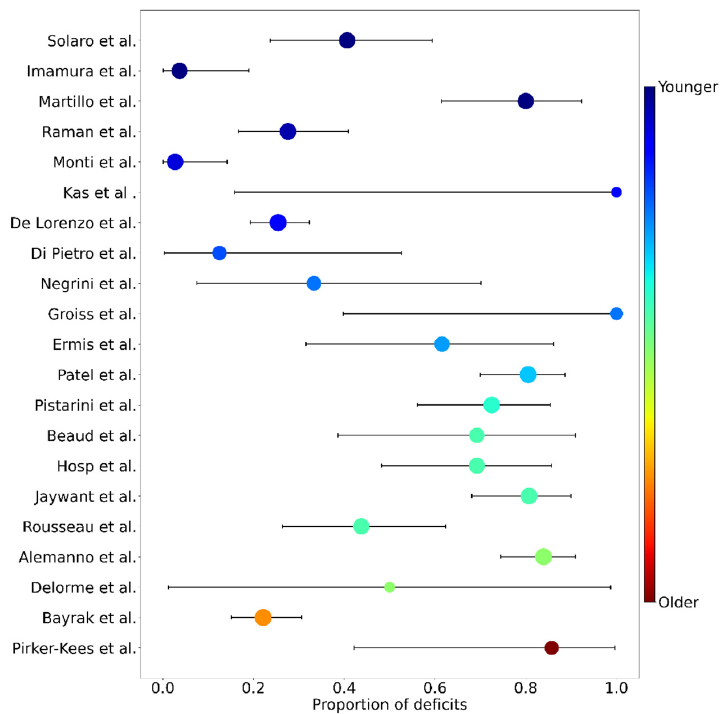
Figure 2. Forest plot of proportions of cognitive deficits for each study, as measured by global scales. Studies are sorted in increasing (from top to bottom) average age (from 54 to 78 years old). Dot sizes are proportional to the random effect weight, whiskers are the 95% confidence interval (both based on the sample size) and colors represent the average age (blue: younger; red: older). Studies are identified by their first author (y axis) and correspond to the following publications (from top to bottom): Solaro et al. [25]; Imamura et al. [26]; Martillo et al. [19]; Raman et al. [31]; Monti et al. [28]; Kas et al. [32]; De Lorenzo et al. [35];Di Pietro et al. [38]; Negrini et al. [36]; Groiss et al. [33]; Ermis et al. [18]; Patel et al. [24]; Pistarini et al. [22]; Beaud et al. [34]; Hosp et al. [21]; Jaywant et al. [39]; Rousseau et al. [23];Alemanno et al. [8]; Delorme et al. [37]; Bayrak & Cadirci [29]; Pirker-Kees et al. [40].